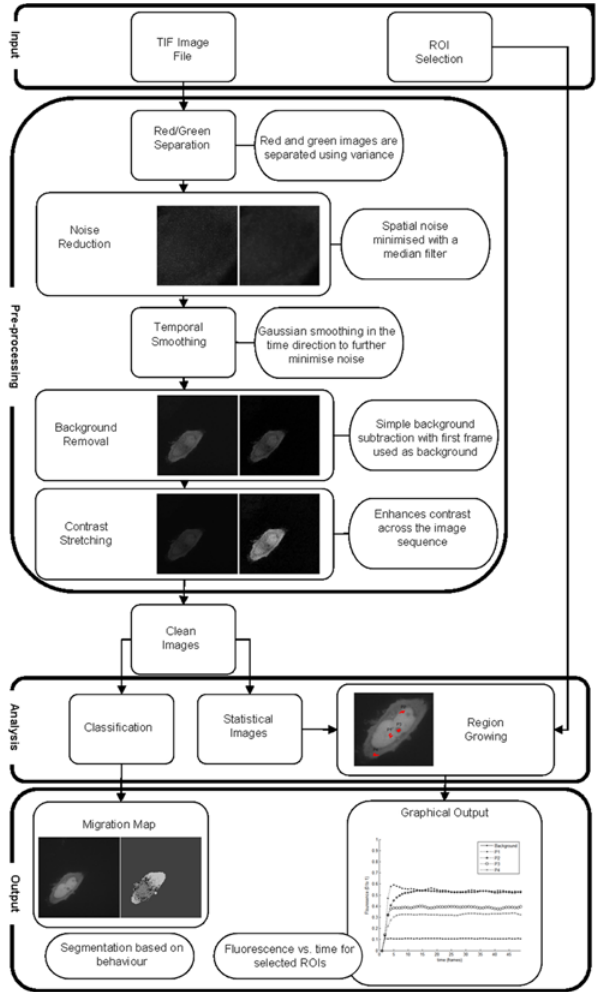
Fig 1. Overview of the image analysis workflow. The data set is exported as a Multi-Tiff file and analyzed using an algorithm developed in MATLAB. Image processing: The processing stage consists of green/red image separation, spatial and temporal noise filtering, background normalization and contrast enhancement. Image analysis: A migration map is generated automatically by classifying the signal variation of individual pixels over the time series. The user selects the location of the ROIs (a single mouse click for each), the regions are automatically created from these seed points and a graph of mean fluorescence of each ROI over time is automatically